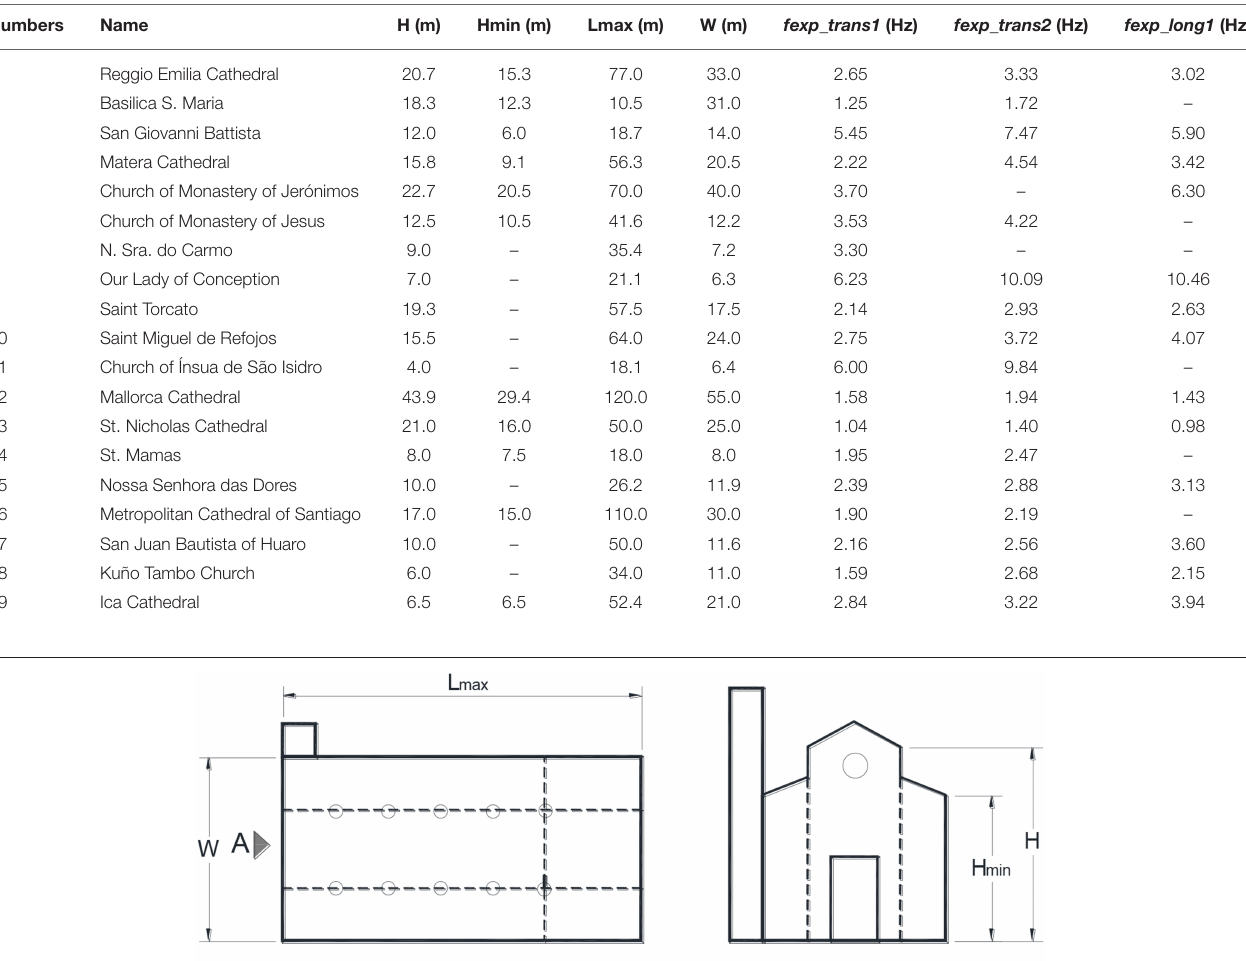
TABLE 3 | Main geometrical characteristics and collected frequencies from the published literature.